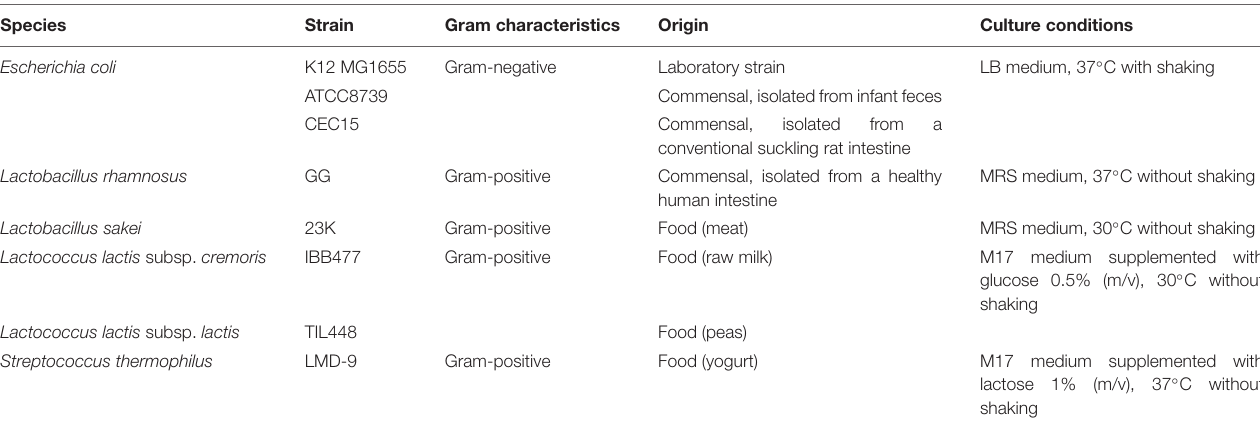
TABLE 1 | List of bacterial strains under study.